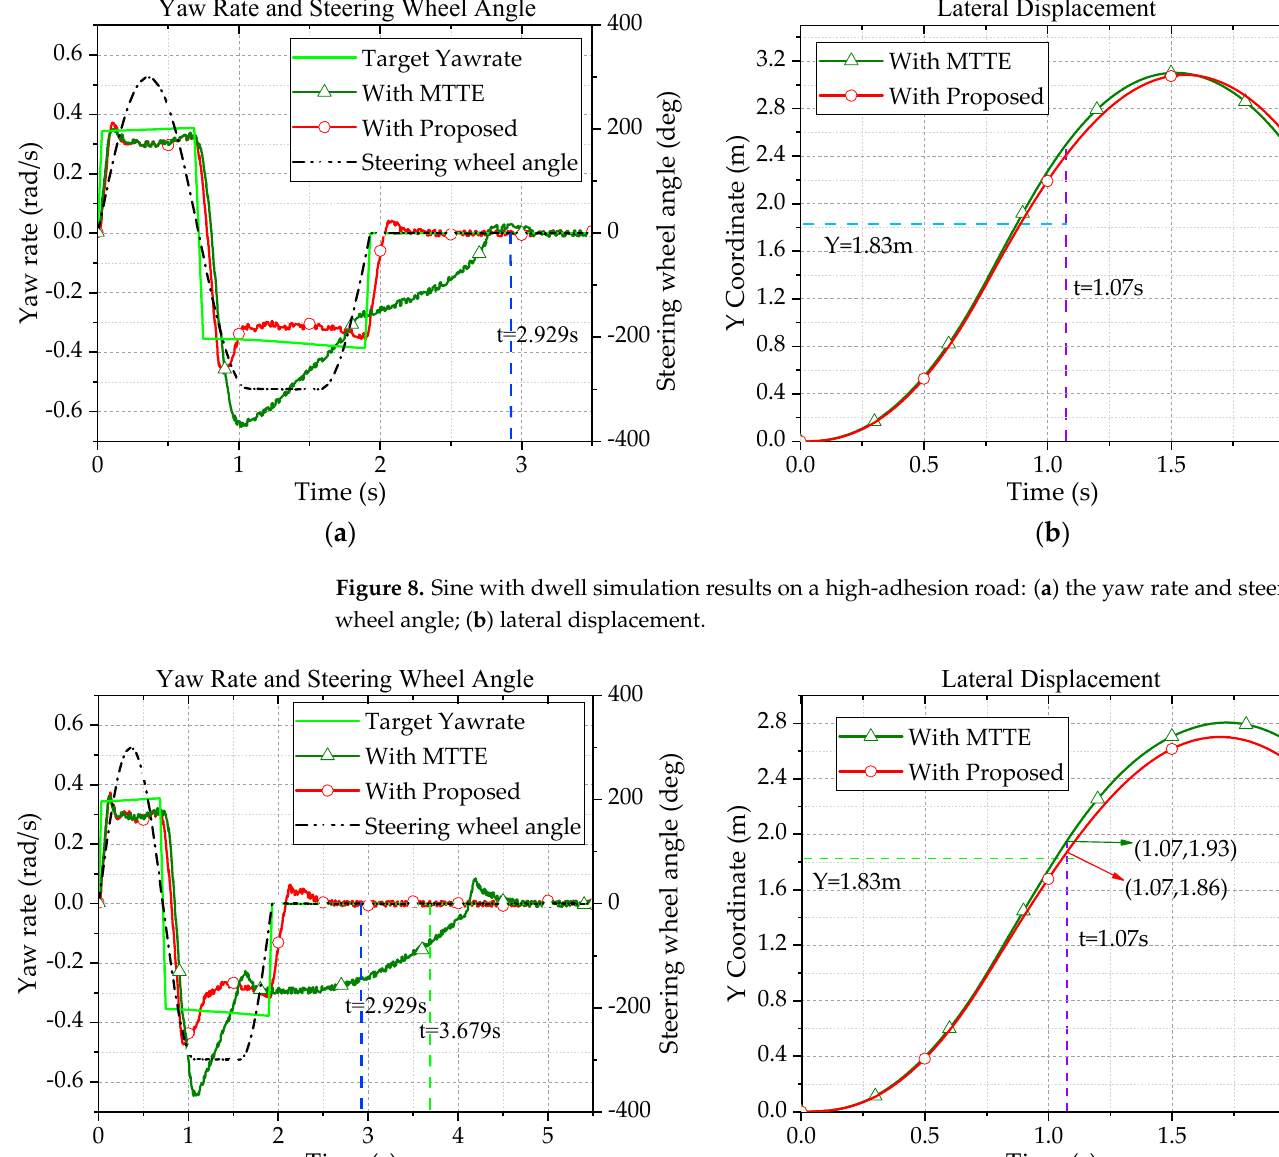
Figure 9. Sine with dwell simulation results on a low-adhesion road: ( a ) yaw rate and steering wheel angle; ( b ) lateral displacement. Table 3. Evaluation of the sine with dwell test.